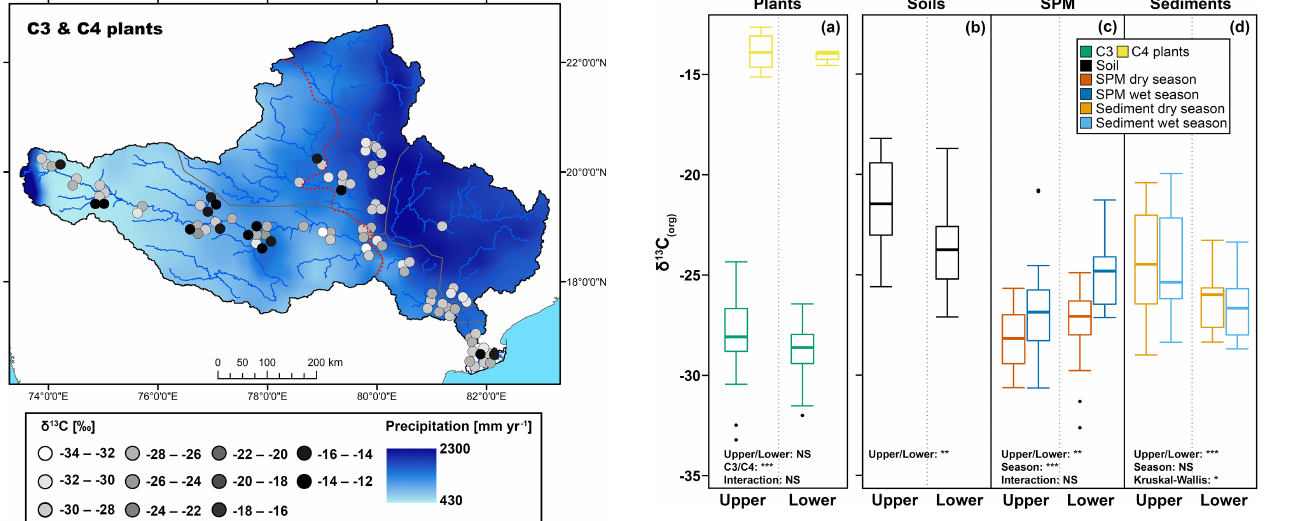
Figure 2. Map showing the spatial distribution of C 3 and C 4 plant δ 13 C values in the Godavari basin. The red dashed line indicates the boundary of the upper/lower basin. The points refer to the measured δ 13 C values and the 30-year average rainfall distribution (MAP; 0.25 ◦ , APHRODITE dataset, Asian Precipitation–Highly Resolved Observational Data Integration Towards Evaluation of Water Re- sources; Yatagai et al., 2012) is shown in the background.